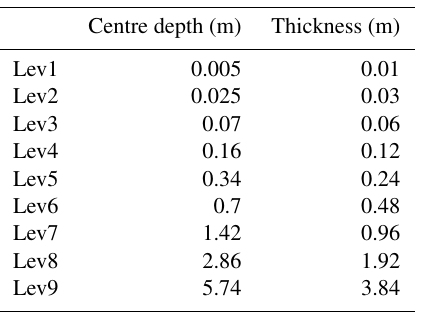
Table 3. Depth of the center of the different active soil layers and their thickness in